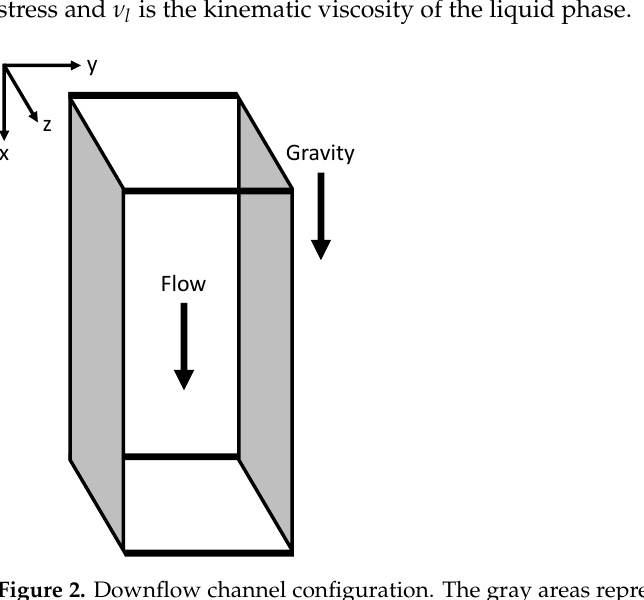
Figure 2. Downflow channel configuration. The gray areas represent the no-slip walls, the x - and z -direction are treated with periodic